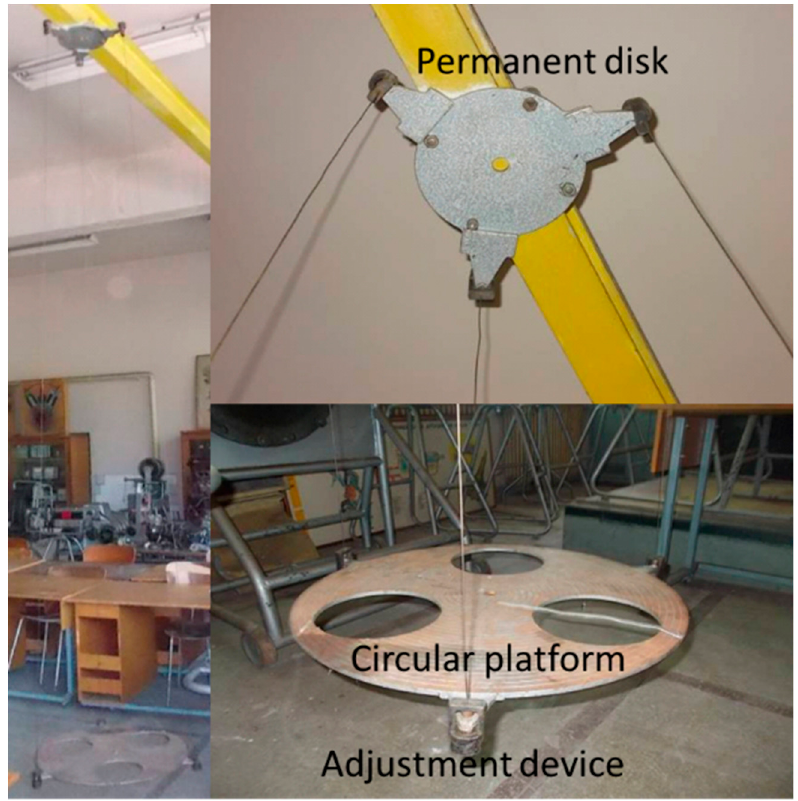
Figure 22. Three-wire pendulum.